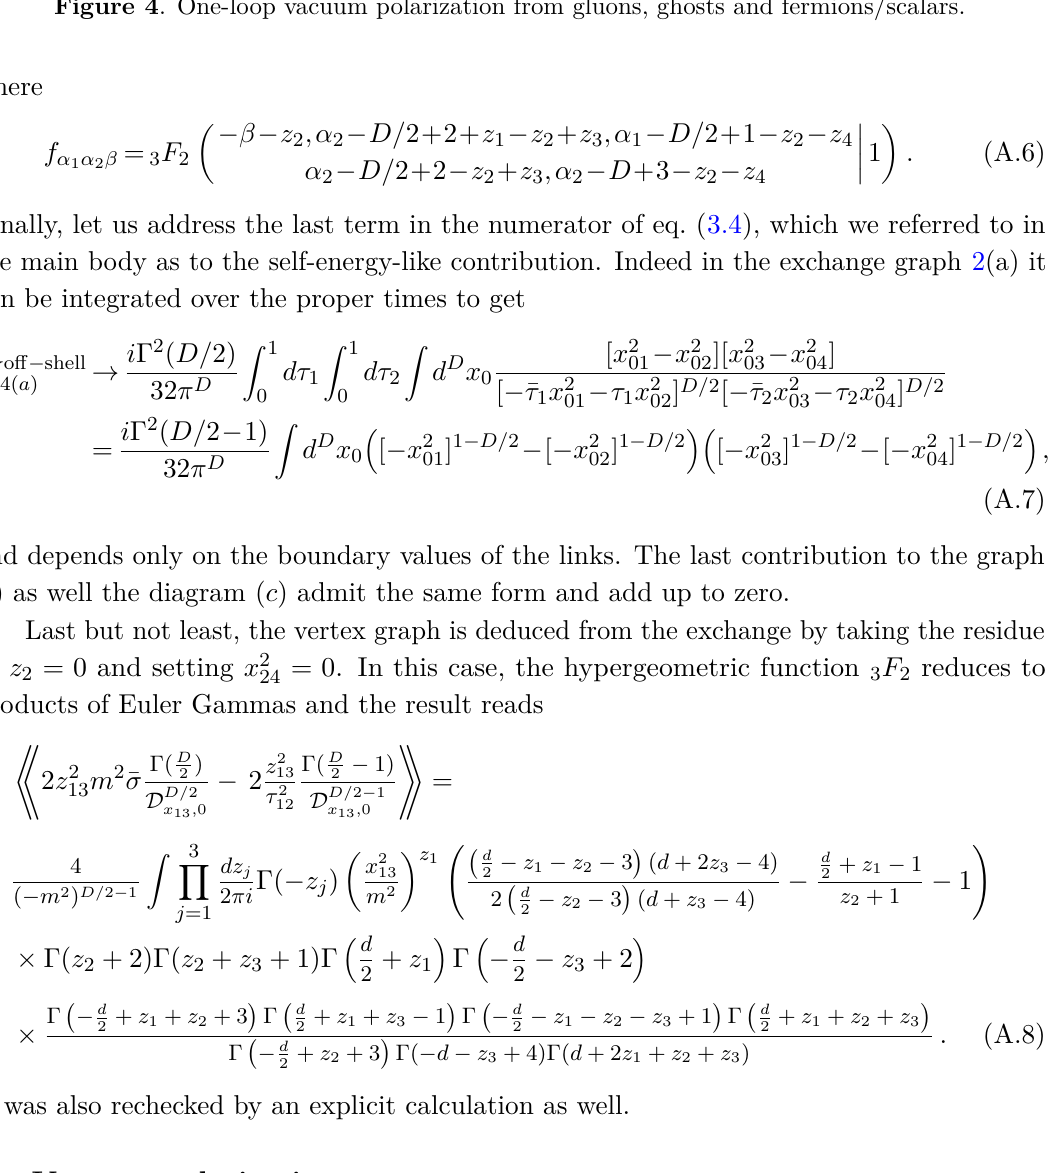
Figure 4 . One-loop vacuum polarization from gluons, ghosts and